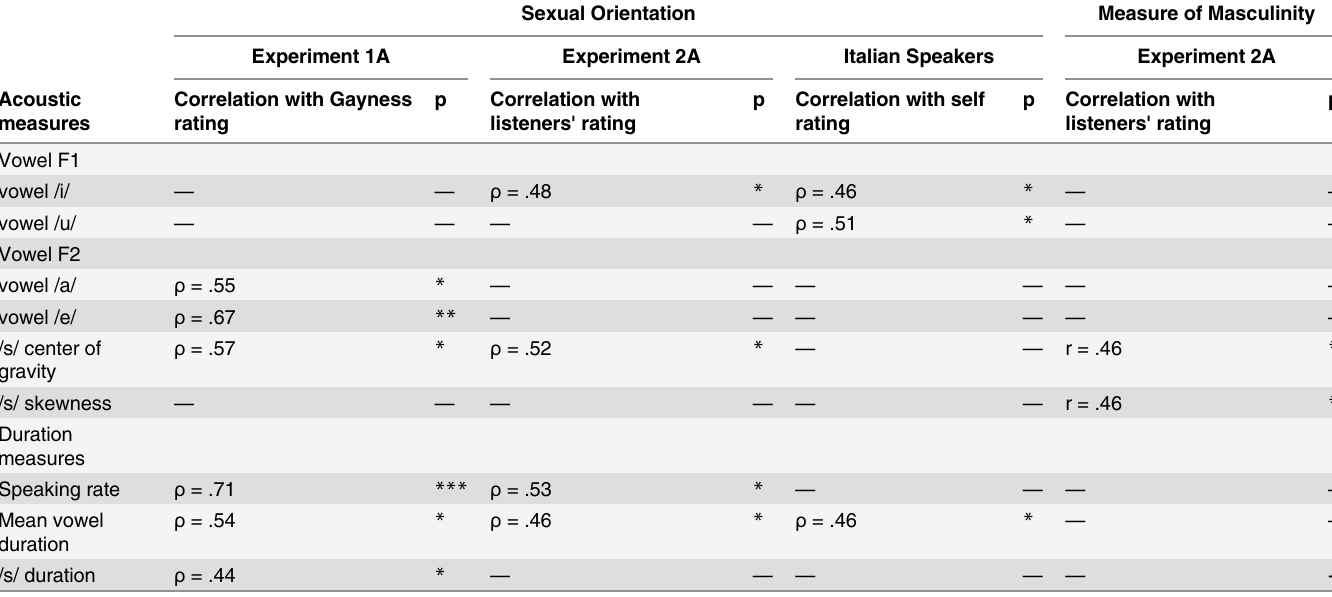
Table 1. Italians – Significant correlations between acoustic cues and participants' judgments of Experiment 1A, 2A, and self-reported speakers'